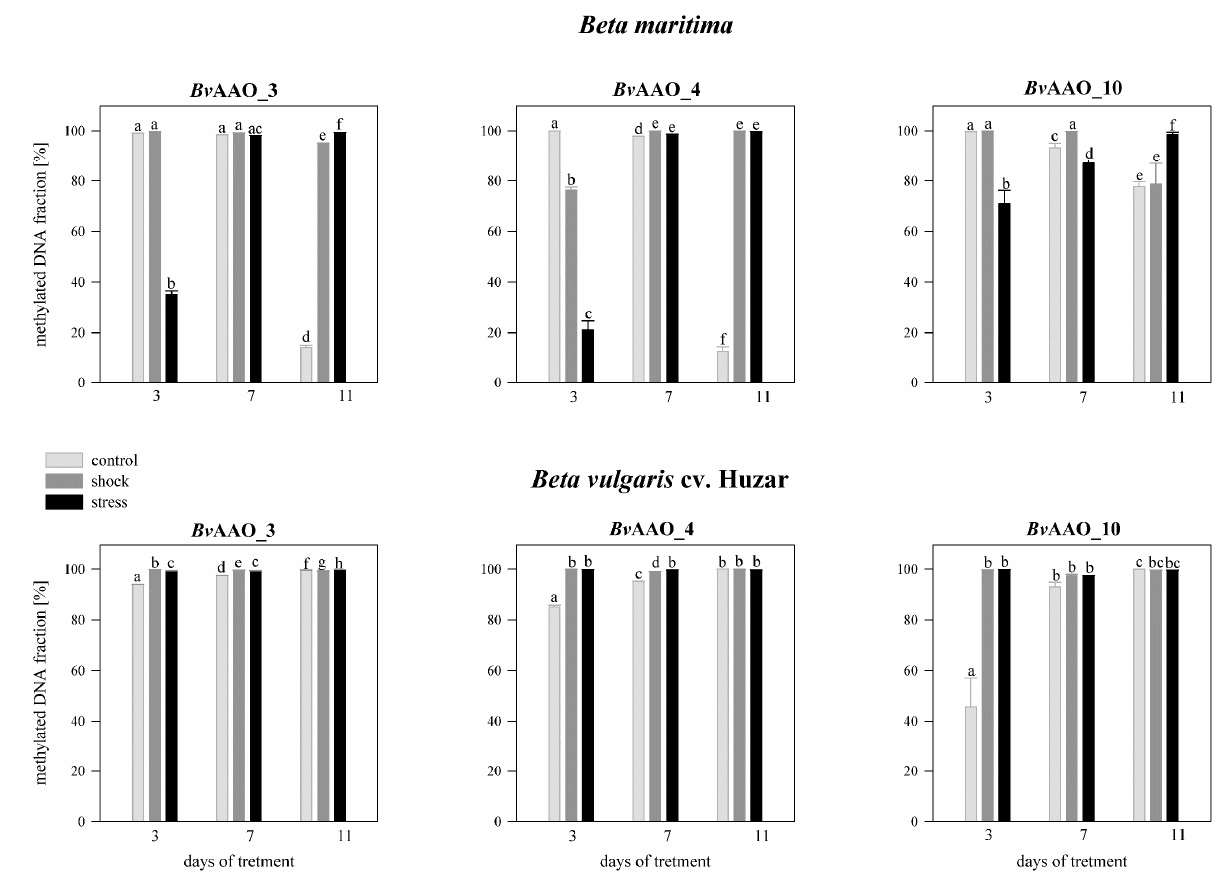
Figure 8. Methylated DNA fraction [%] of CpG islands in the promoter region of AAO genes Bv AAO_3, Bv AAO_4 and Bv AAO_10 determined in leaves of Beta vulgaris ssp. maritima and Beta vulgaris cv. Huzar subjected to drought shock or stress. Control − light gray bars, salt shock − gray bars, salt stress − black bars. Different letters denote significant differences at p < 0.01 (ANOVA followed by Tukey’s test). “whiskers” indicate standard deviation.